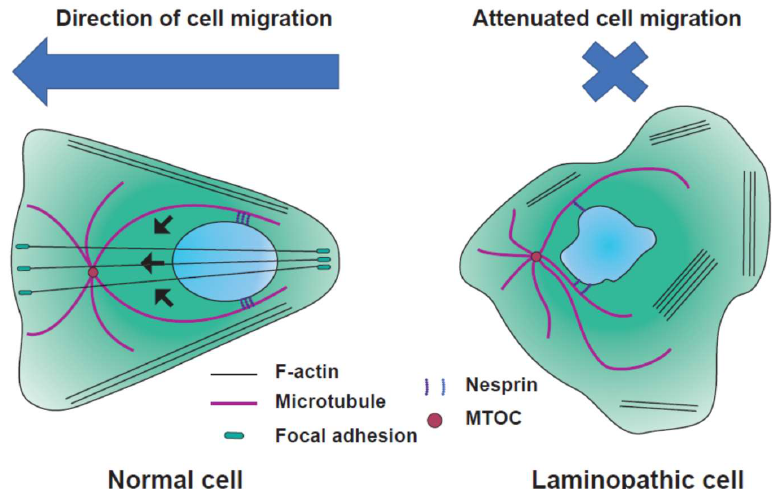
Figure 2. Nuclear positioning in laminopathic cell migration. Left: Normal cells are polarized in the order of “front-end nucleus– microtubule-organizing center (MTOC) rear end”. Black arrows indicate the direction of nuclear migration. Blue arrow shows the direction of cell migration. Right: Laminopathic cells have a deformed nucleus and weak connection between the nucleus and cytoskeleton. Since F-actin formation is disturbed in laminopathic cells, laminopathic cells lose their directionality in cell